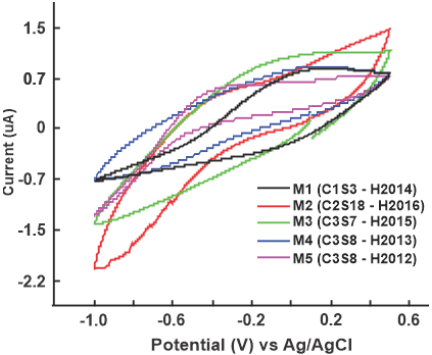
Figure 4. Voltammetric signals of the S1 sensor (PPy/SO 4 ) recorded in different samples of drinking